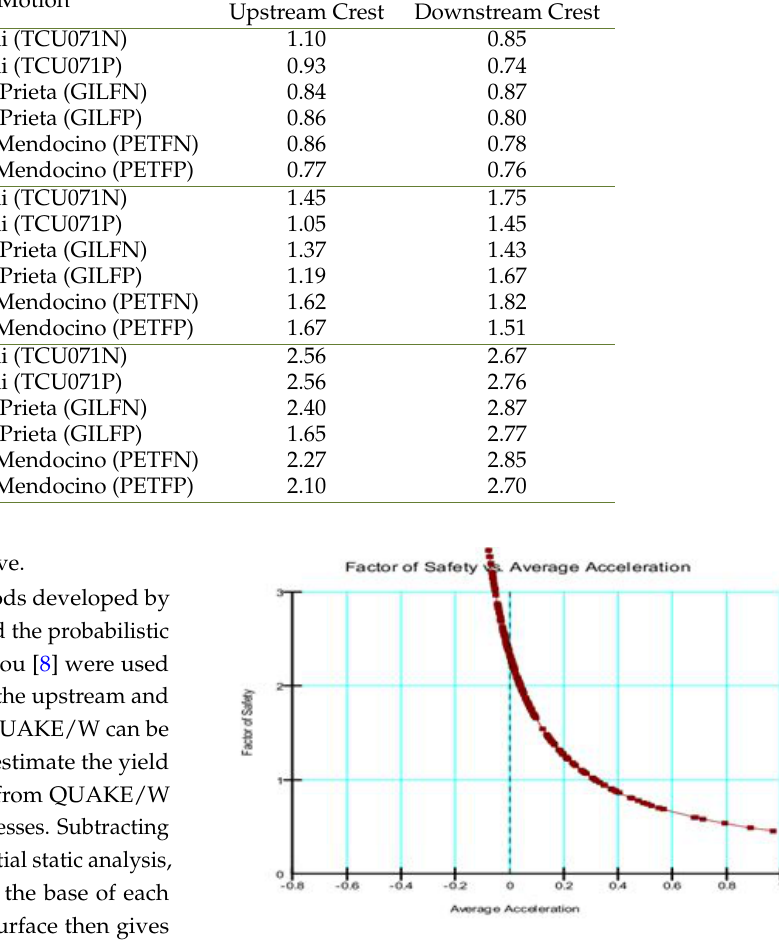
Fig. 6. Upstream Slope Factor of Safety vs Average Acceleration- Input Motion